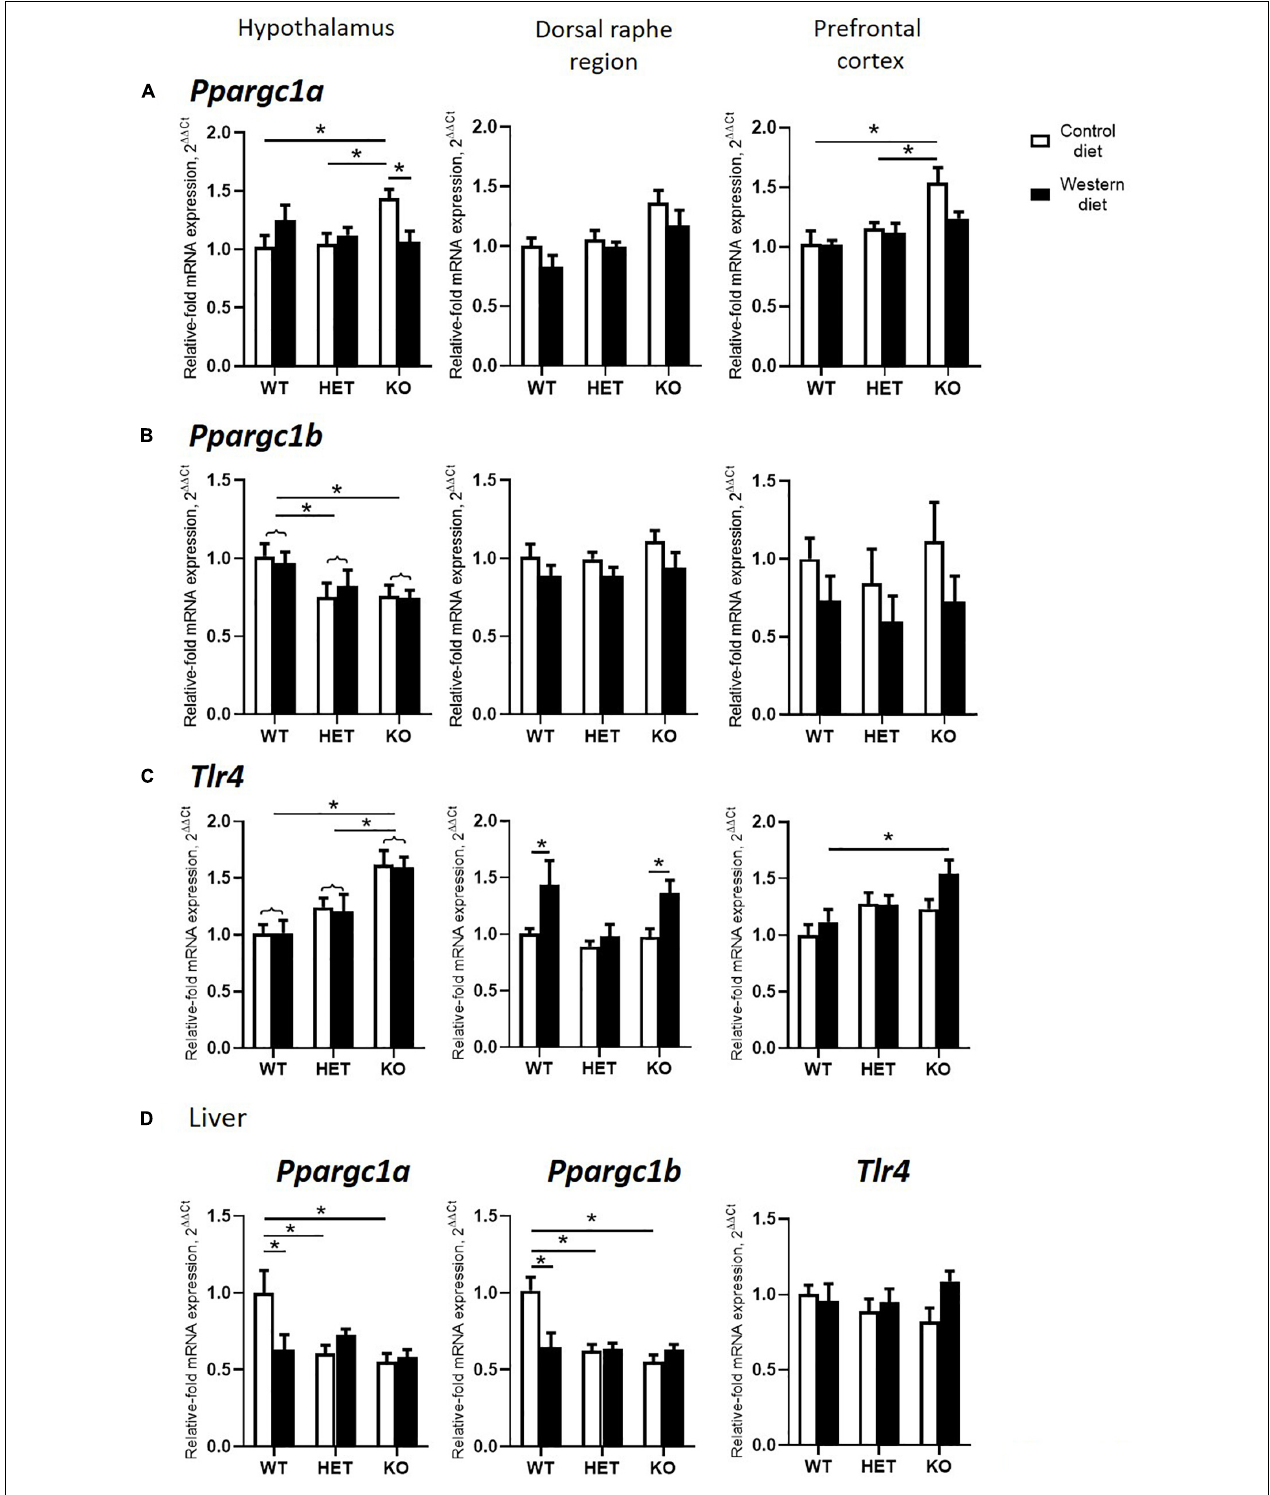
FIGURE 4 | Effects of Western diet and SERT deficiency on brain and liver gene expression of markers of mitochondrial activity and Tlr4 . (A–C) Ppargc1a , Ppargc1b , and Tlr4 expression in hypothalamus, dorsal raphe region, and prefrontal cortex. Tlr4 expression in dorsal raphe region was significantly increased in WT and KO, but not HET mice fed with WD, compared to respective groups fed with CD. (D) Ppargc1a , Ppargc1b , and Tlr4 expression in the liver. * p < 0.05, two-way ANOVA and Tukey’s test, main genotype effect is marked with braces, six to seven animals per group were used. Data are shown as mean ± SEM.